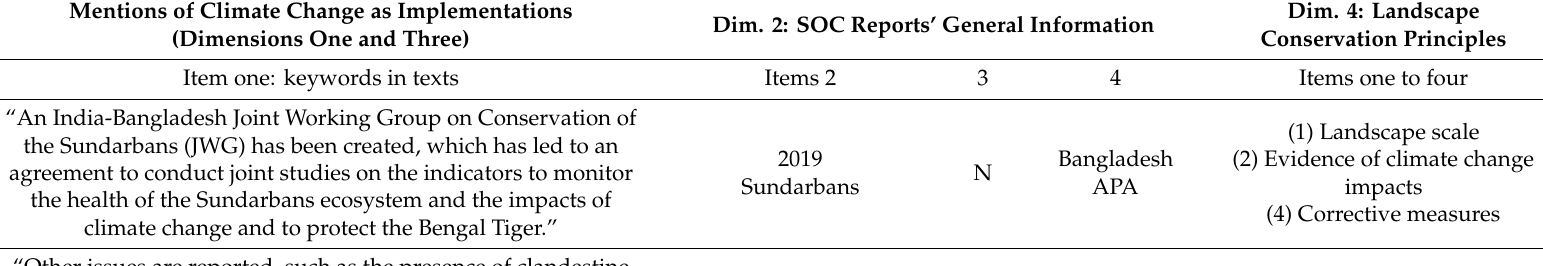
Table 3. Example of analysis implementations (item 3.2) and landscape conservation principles (dimension